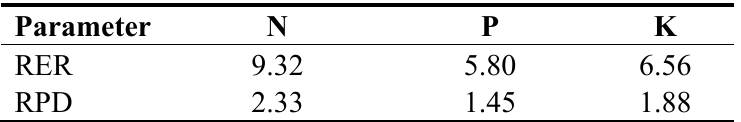
Table 3. Calibration performance assessment data showing ratio of standard error of prediction to range of reference data (RER) and ratio of standard error of prediction to standard deviation of reference data